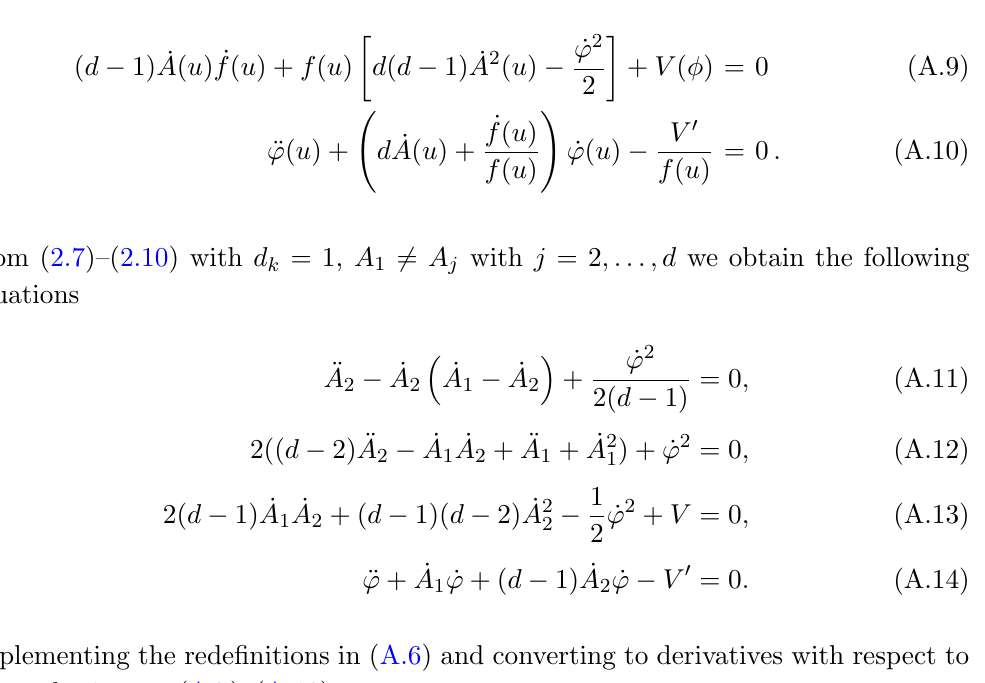
‘ 3 . The point where the p